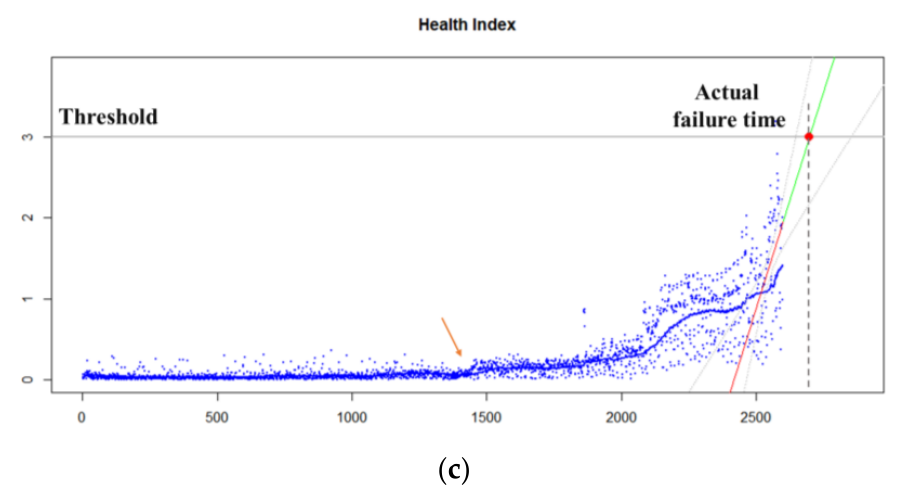
Figure 6. The result of pump data. ( a ) Constructed HI model on pump No. 1; ( b ) Constructed HI model on pump No. 2; ( c ) Constructed HI model on pump No. 3.